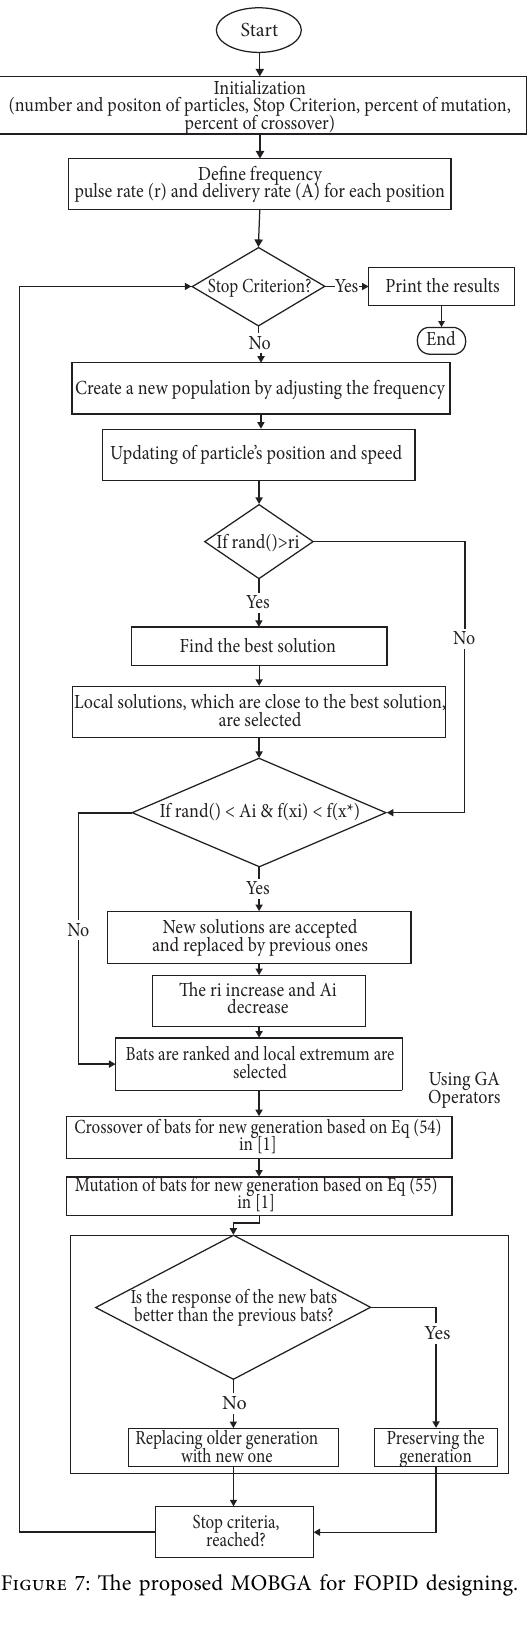
Figure 7: The proposed MOBGA for FOPID